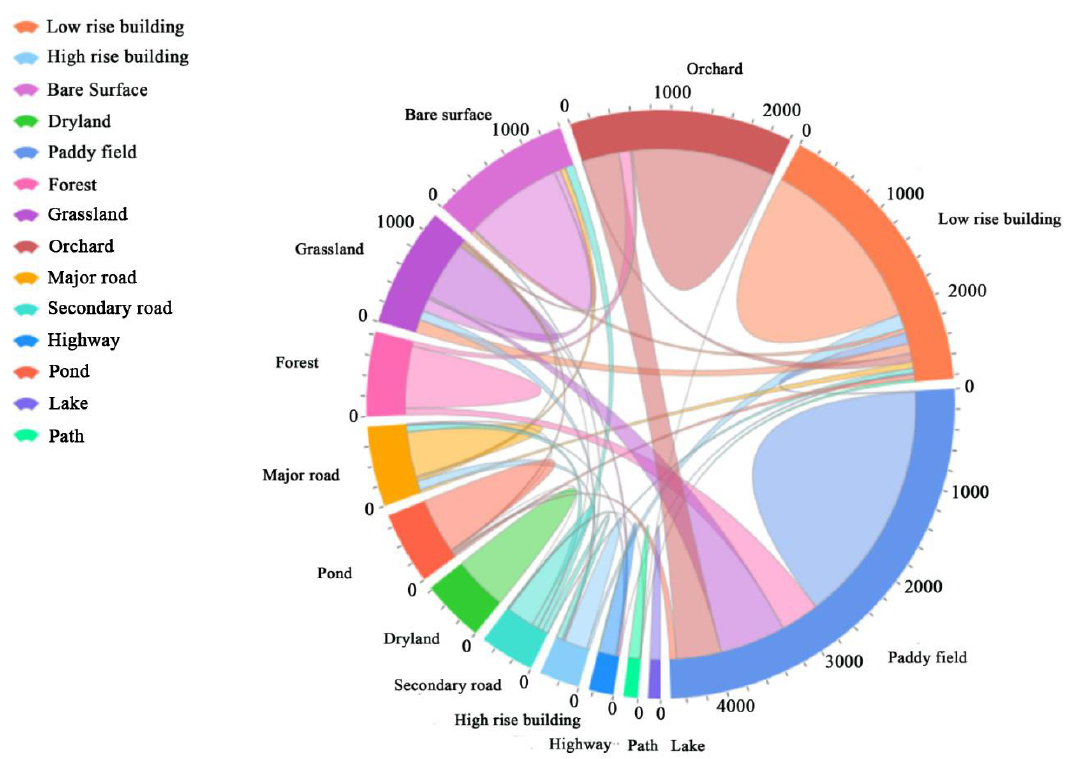
Figure 6. The chord chart of confusion matrix for land cover extraction. Different colors represent different land cover classes. Length of the arc for each class represents the number of pixels, the unit is thousands of pixels. The link strips between different classes mean the pixels of the objects that are incorrectly classified into the other class.